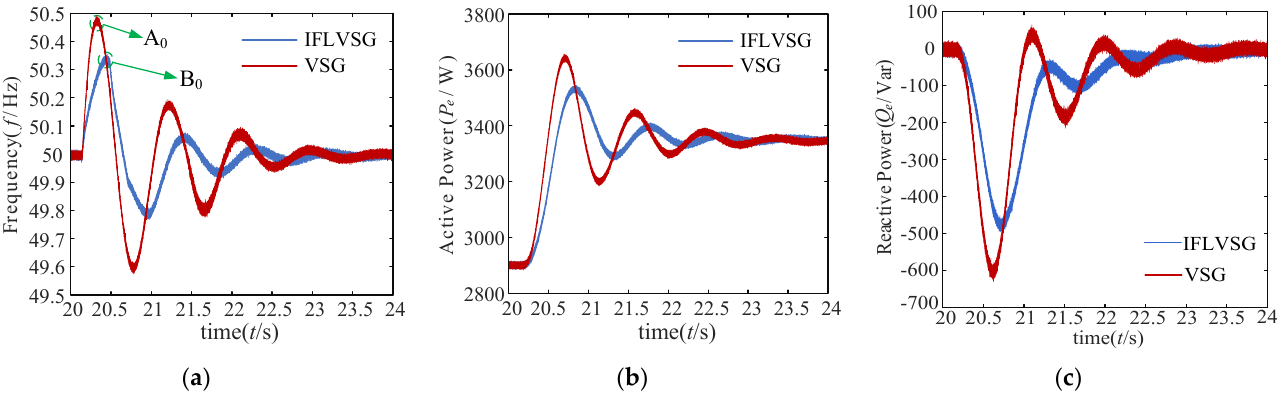
Figure 10. Comparison of results between the VSG control strategy and the IFLVSG control strategy: ( a ) System frequency waveforms; ( b ) Output waveforms active power. ( c ) Output waveforms reactive power.